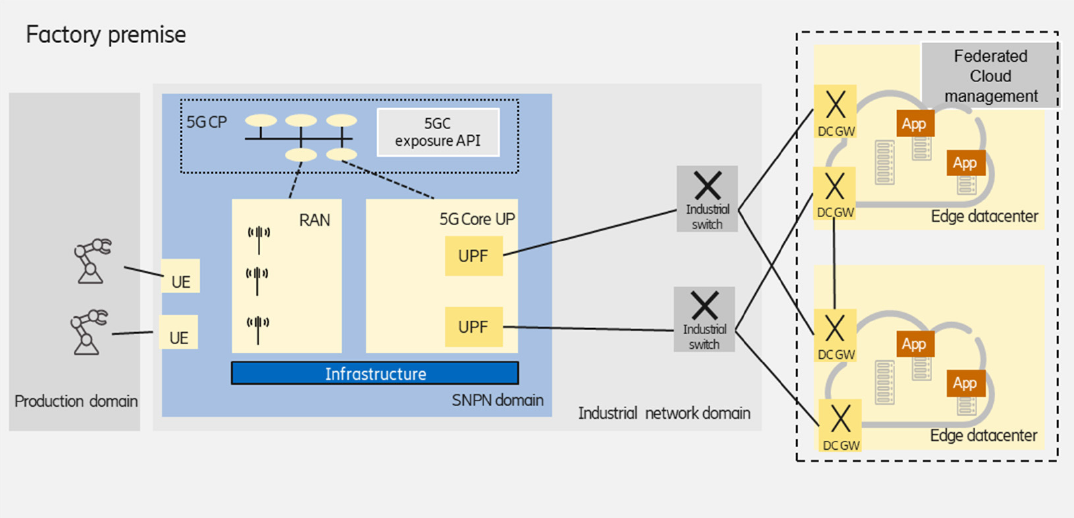
Figure 3. Federated edge data centers in factory premise.